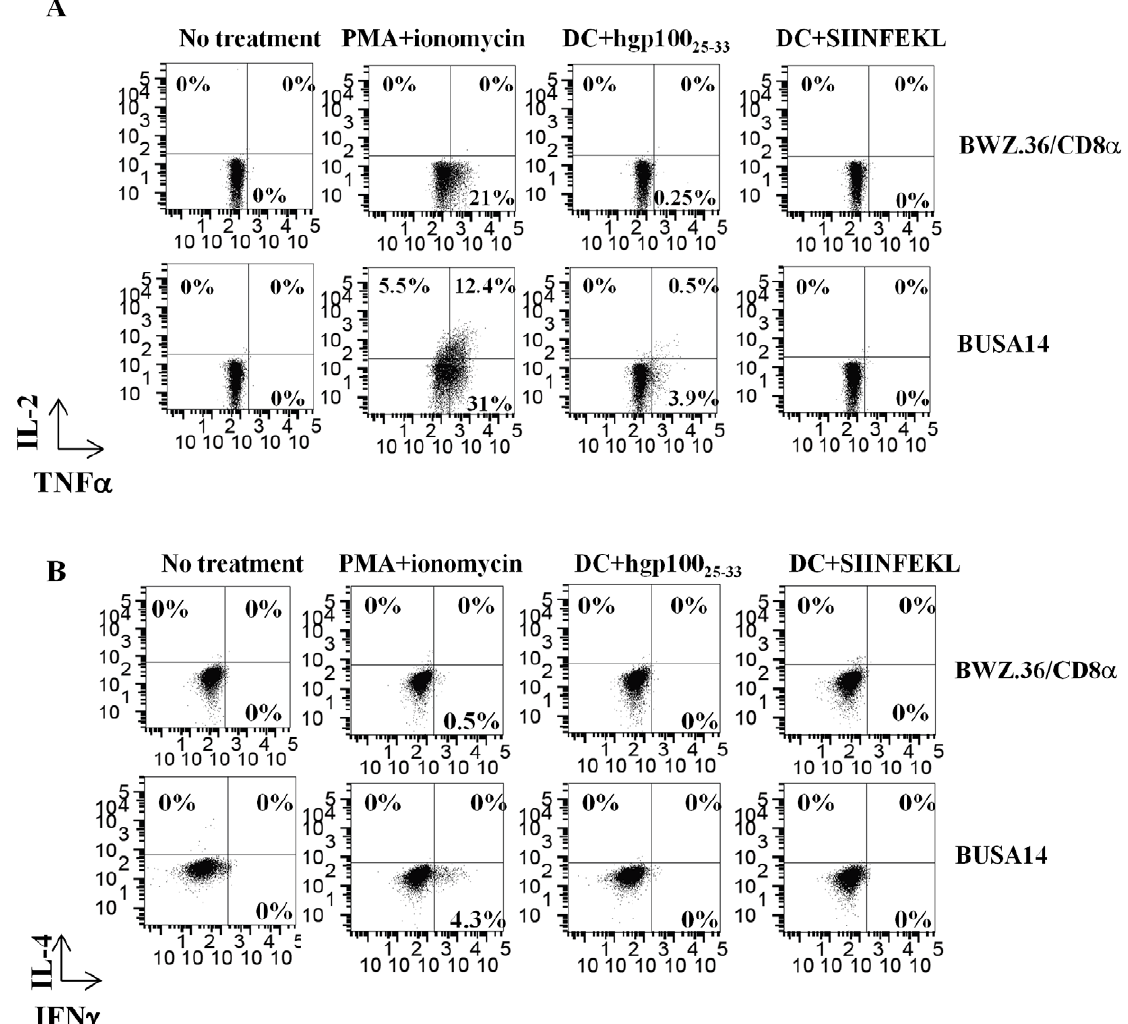
Figure 3. Detection of cytokines produced by BUSA14 cells. BUSA14 or BWZ.36/CD8 a were co-incubated with DC2.4 cells loaded with